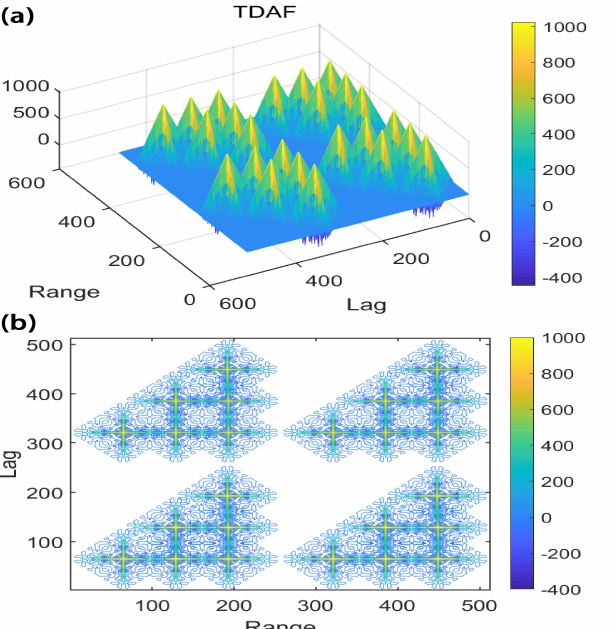
Figure 4. ( a ) TDAF of 4-bit strong alternating code modulated by 16-bit complementary code and ( b ) corresponding contour plot.